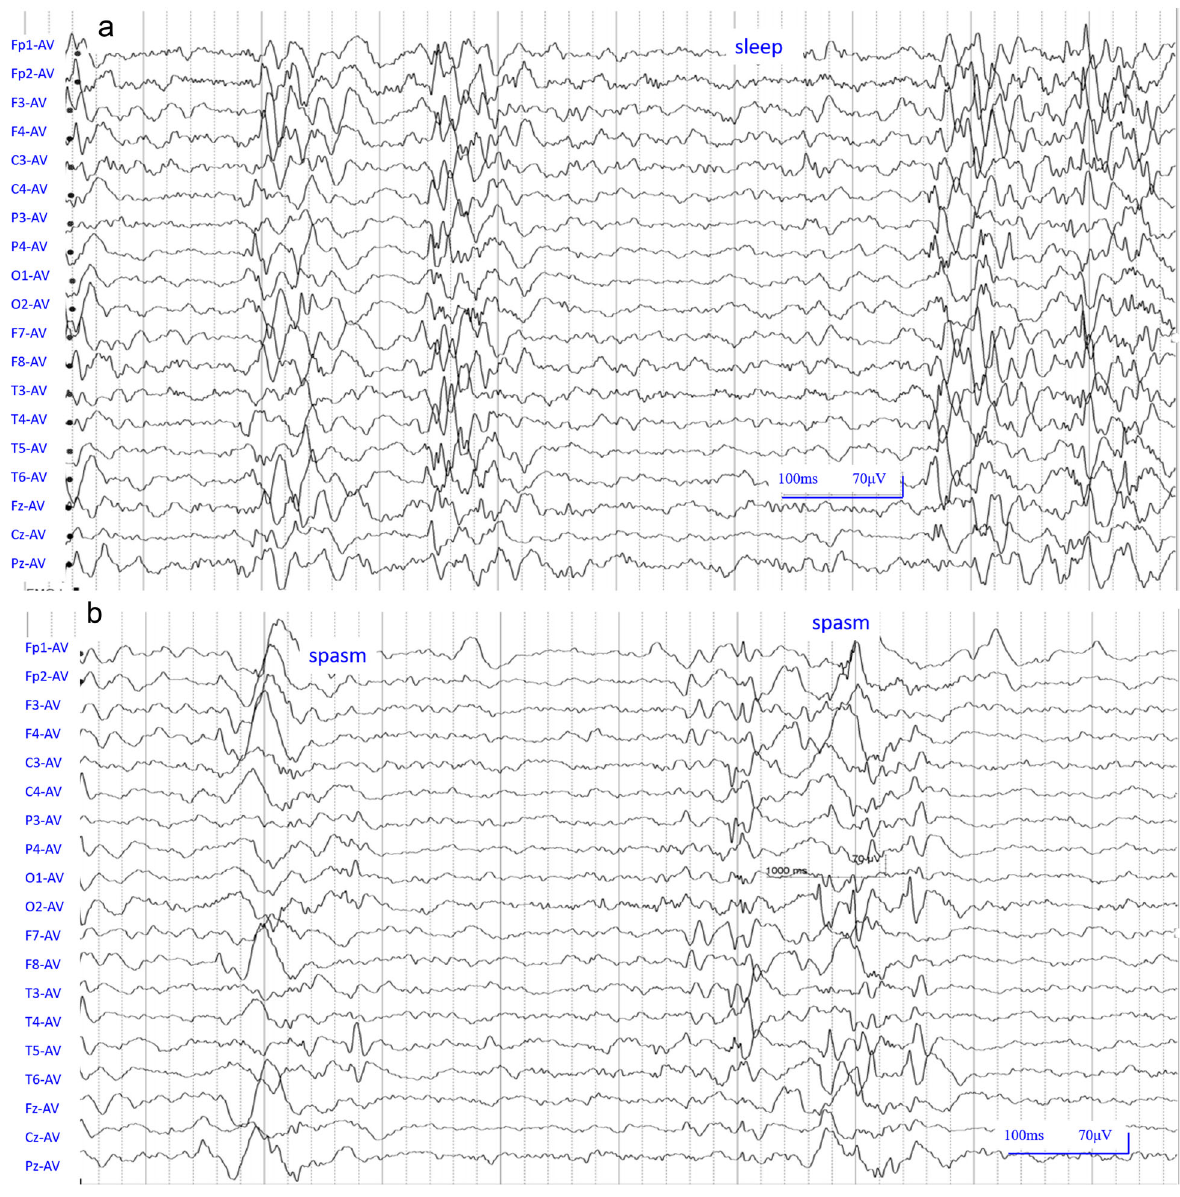
Fig. 2 The second electroencephalogram (EEG) of the patient. a : interictal EEG, periodical hypsarrhythmia, diffuse irregular medium-high amplitude slow waves mixed with a large number of disorderly multifocal spikes and sharp waves, which were asymmetrical, synchronous/asynchronous. b : ictal EEG, epileptic spasm occurred with irregular high amplitude slow waves followed by short fast activities during the EEG